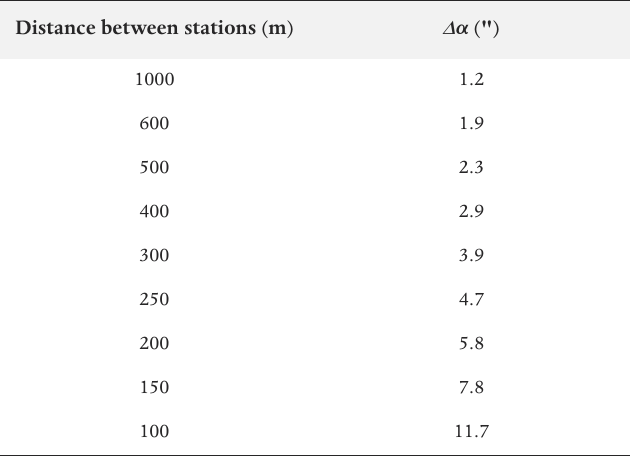
Table 7. Dependence of the azimuth accuracy and the distance between